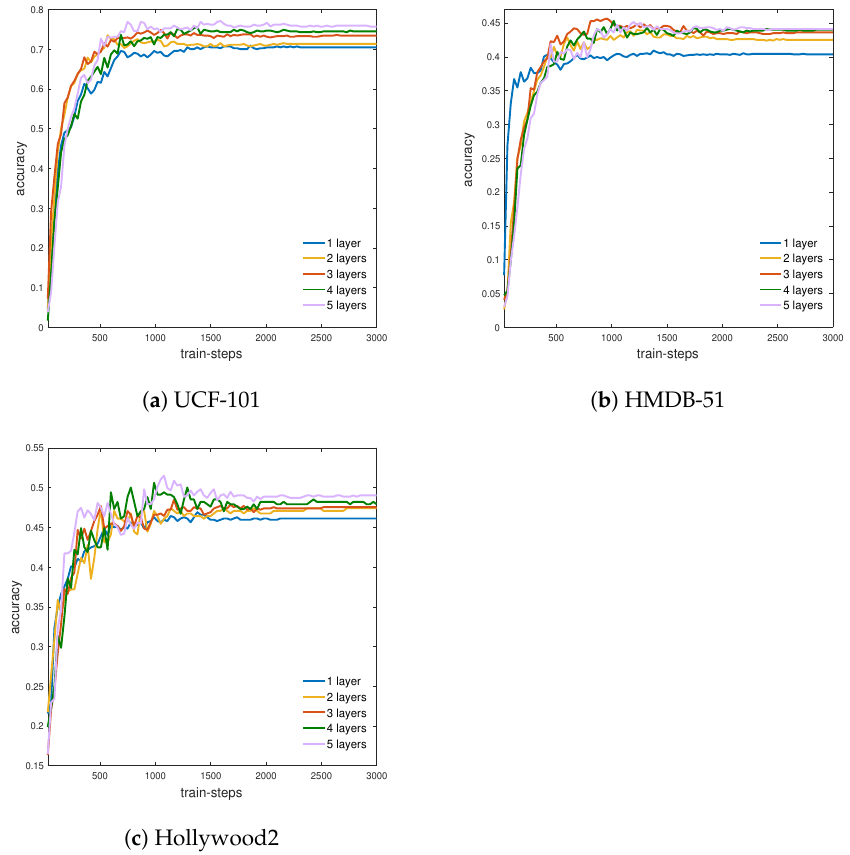
Figure 6. The comparison of the accuracy increasing process of stacked ST-D LSTM units with different